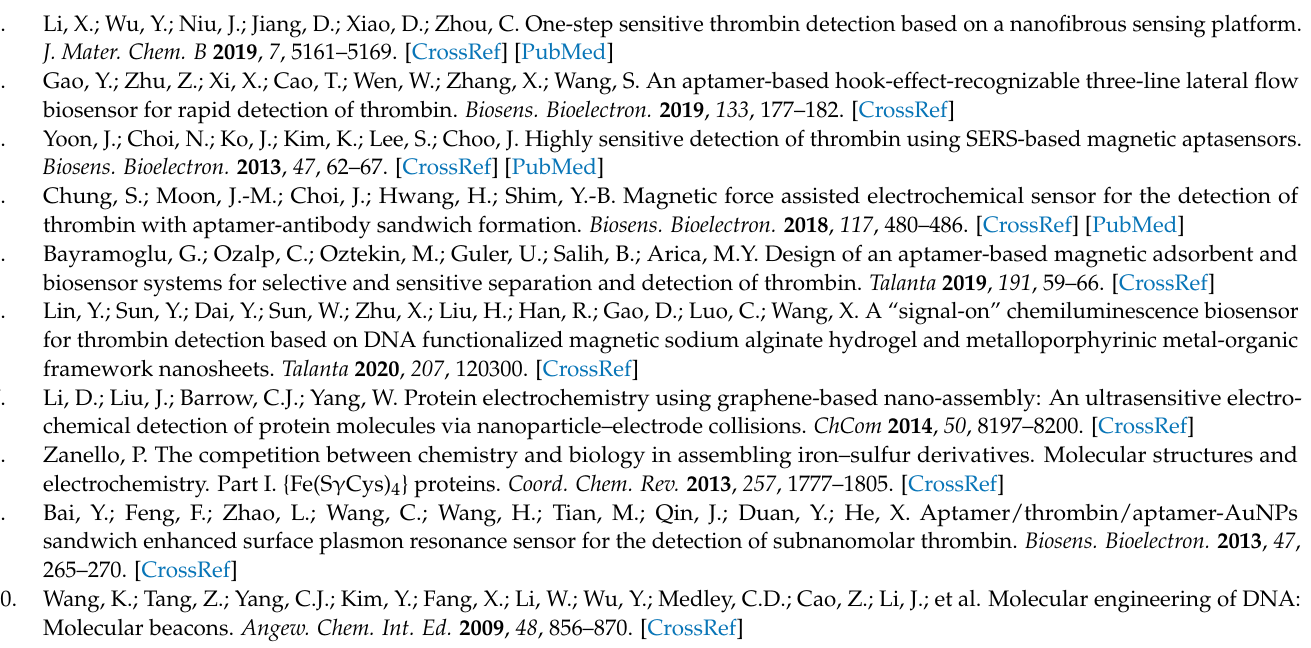
thrombin; Figure S5. The fluorescence intensity of TBA changing with time (Black:10 nM DNA-20 µ g/ml GO, Red: 10 nM DNA-20 µ g/ml GO- (1nM) Thrombin-Exonulase (0.03 U/ µ L); Figure S6. The Influence of buffer environment for the detection of